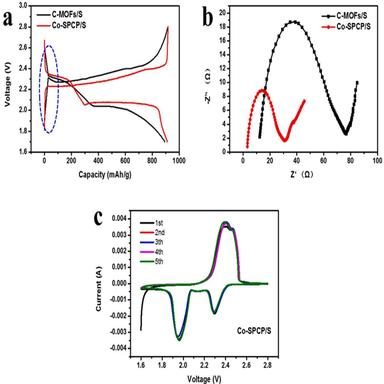
The charge/discharge potential profiles at the current density of 1 C (a), the Nyquist plots (b) of Co-SPCP/S and C-MOFs/S cathodes, CV curves of the Co-SPCP/S cathode from the 1st to 5th cycle over a voltage range of 1.6–2.8 V at a sweep rate of 0.2 mV s−1 (c).